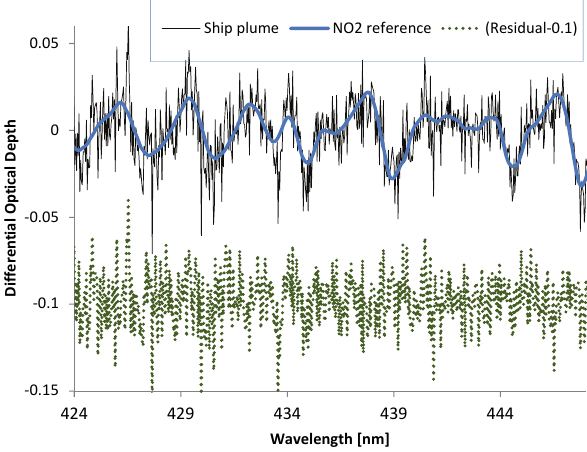
Fig. 1. A ship plume measurement of SO 2 corresponding to the plume in Fig. 7. The differential optical depth is shown when nor- malizing spectra inside and outside the ship plume, respectively, and correcting for the ring spectrum. In addition a fitted reference spec- trum of SO 2 is shown. The lower part shows the residual after the fitting procedure.